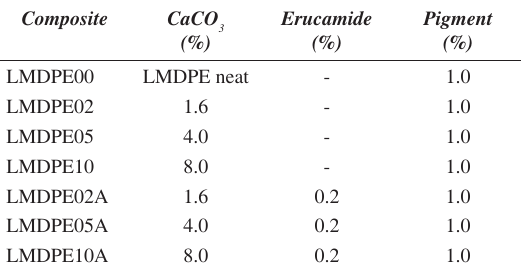
Table 1. Composites formulations.